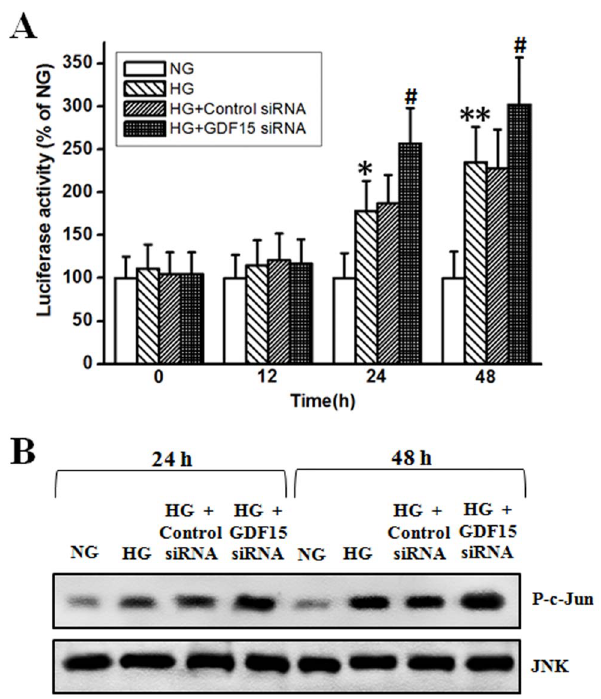
Figure 6. Inhibition of adaptively induced GDF15 expression promoted NF- k B/JNK activation. GDF15 siRNA or negative control siRNA were transfected into HUVEC cells. 12 h after transfection, HUVEC cells were treated with normal (5.5 mmol/l) or high (33.3 mmol/l) glucose. A, at indicated time points, NF- k B luciferase activity was detected using a Cignal NF- k B reporter (luc) kit as described in the materials and methods. B, JNK activity was detected by a JNK activity assay kit using recombinant c-Jun as substrate as described in the materials and methods. NG, normal glucose. HG, high glucose. *, P , 0.05, **, P , 0.01 versus NG. # , P , 0.05 versus HG.